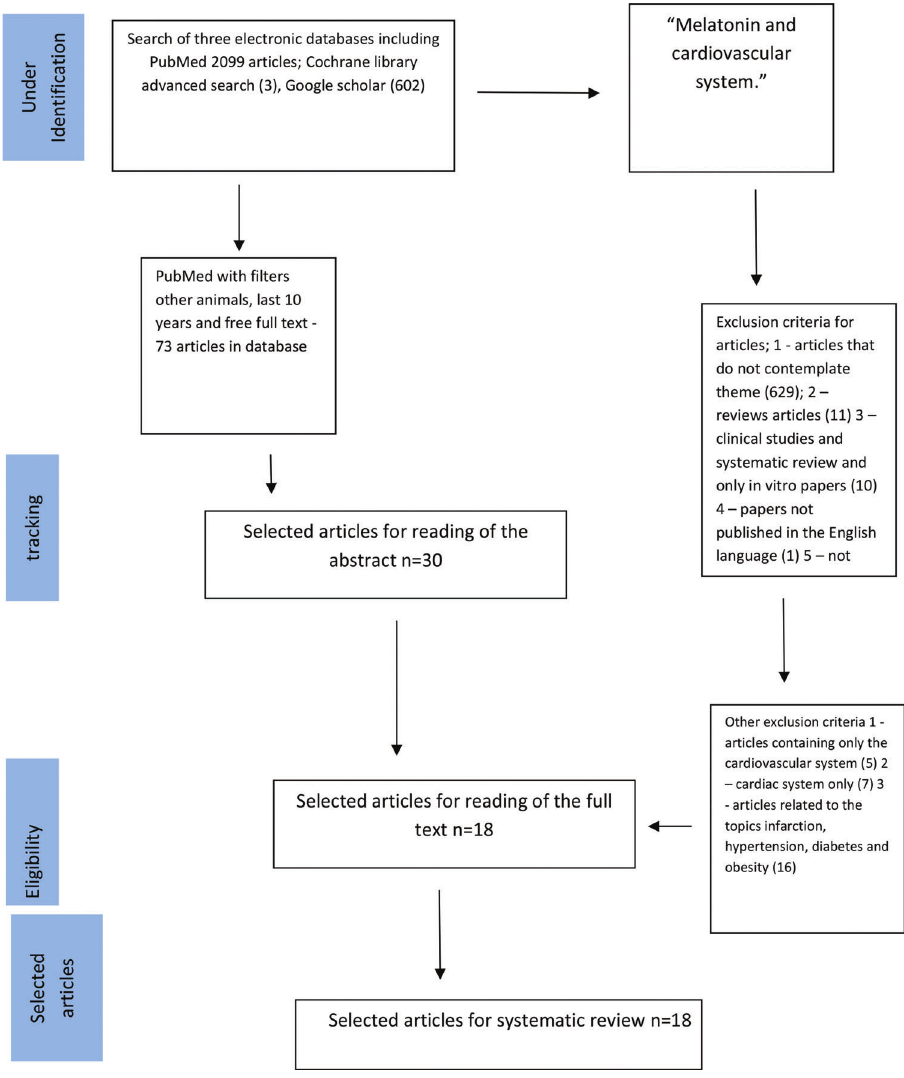
Figure 1 - Flow chart of experimental